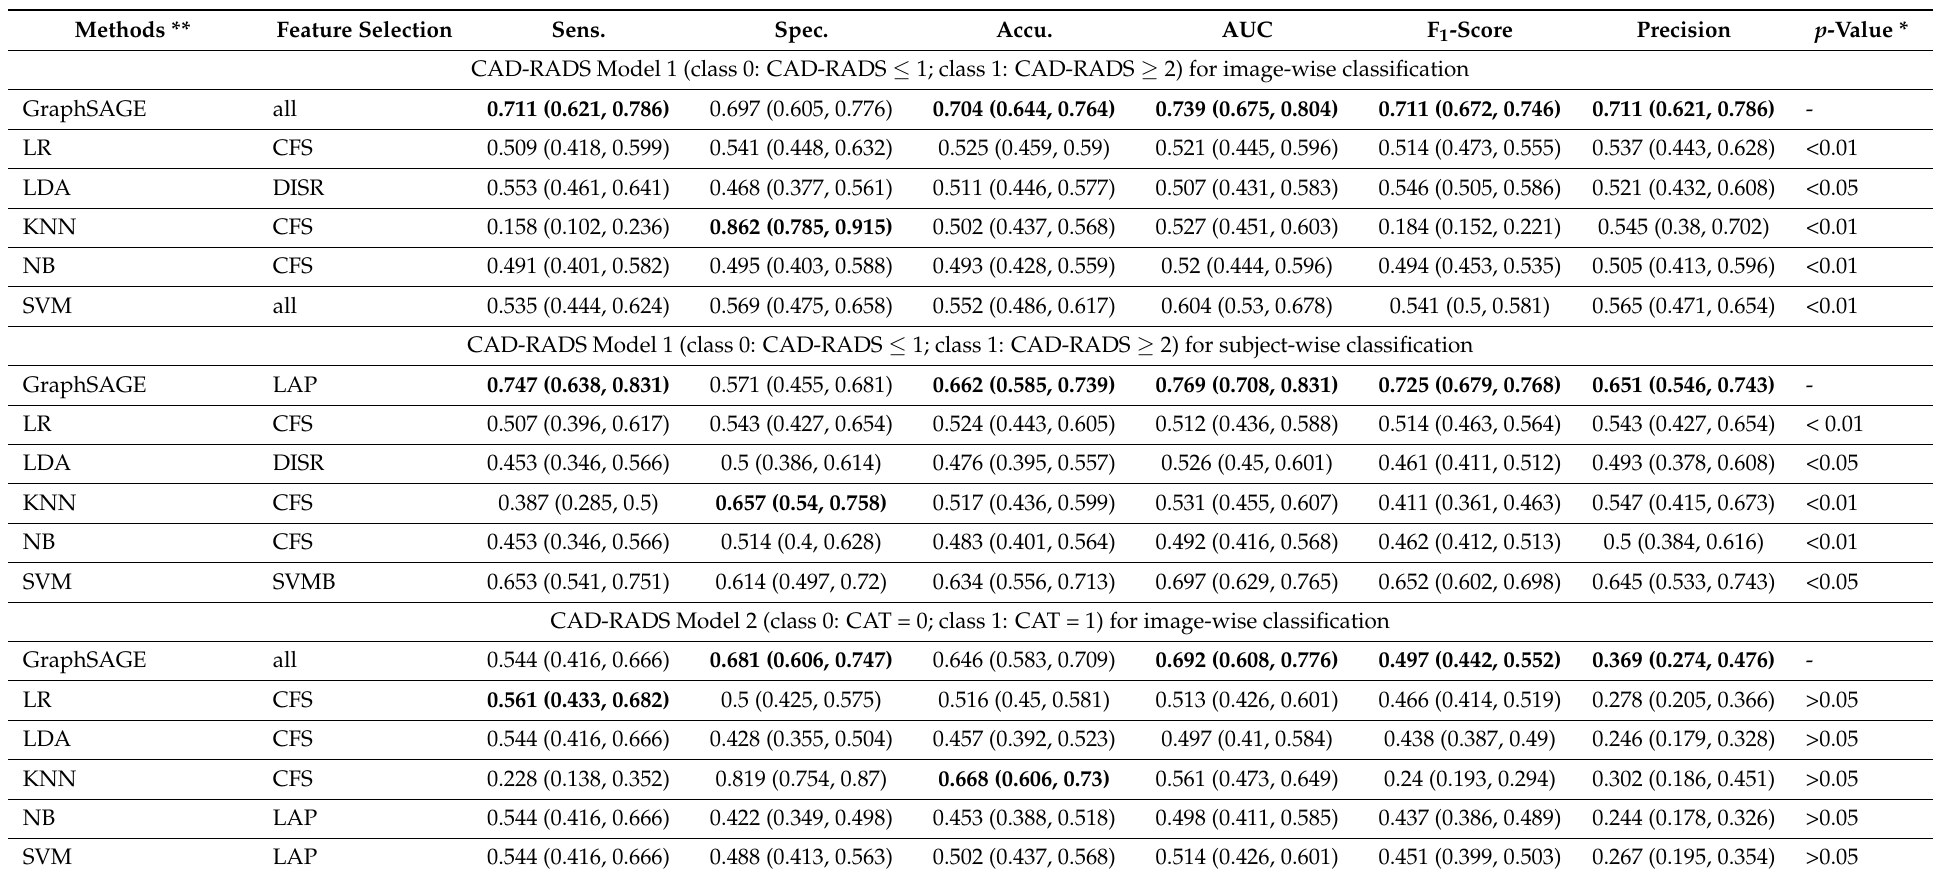
Table 3. The classification performance of GraphSAGE and other machine learning models on the CAD-RADS model 1 and model 2, in terms of image-wise and subject-wise classification. Bolded values indicate the best performance across the